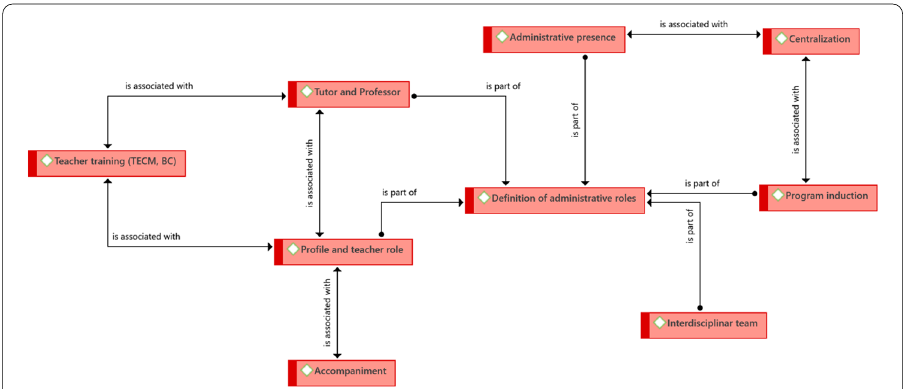
Fig. 8 Structure of driving ideas associated with the organizational perspective. Source: Diógenes